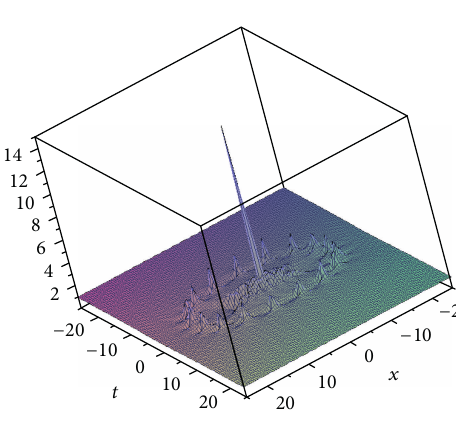
analytical expression of the Peregrine breather of order nine is